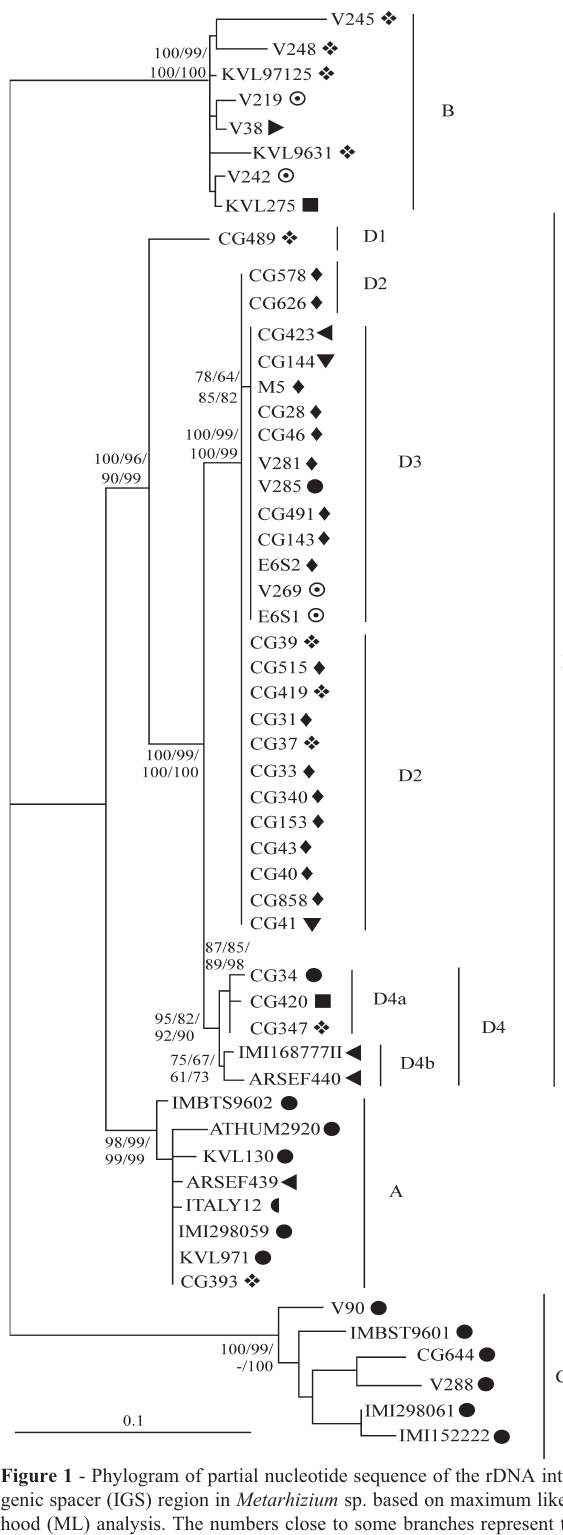
Figure 1 - Phylogram of partial nucleotide sequence of the rDNA inter- genic spacer (IGS) region in Metarhizium sp. based on maximum likeli- hood (ML) analysis. The numbers close to some branches represent the support values obtained from ML, number joining, maximum parsimony or Bayesian inference respectively. For clarity, we only present those val- ues related to the groups discussed in the text. Symbols indicate the envi- ronment or host from which the isolate was obtained: (cid:2) Soil; (cid:3) Coleop- tera; (cid:2) Dermaptera; (cid:3) Hemiptera; (cid:4) Homoptera; ■ Hymenoptera; (cid:2) Lepidoptera; (cid:4) Orthoptera; (cid:3) unknown